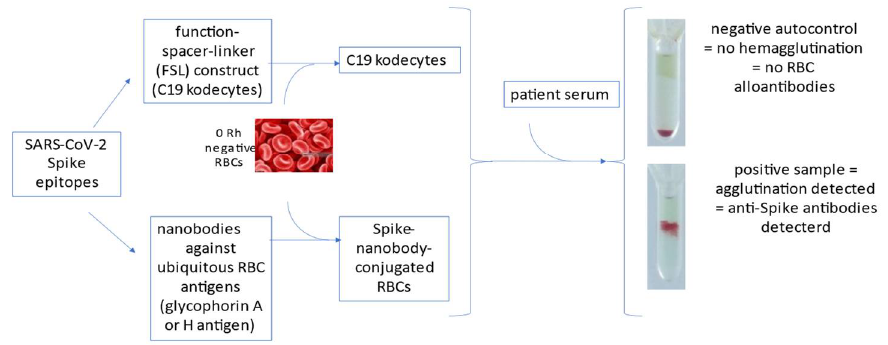
Figure 1. Summary of HAT-exploiting technologies for COVID-19 serology. Anti-Spike antibodies can be detected by hemagglutination when epitopes are bound to red blood cells (RBCs) either via function–spacer–linker (FSL) constructs or nanobodies.